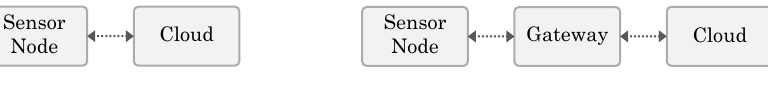
Figure 2. Typical system architecture in an IoT-based parking system.